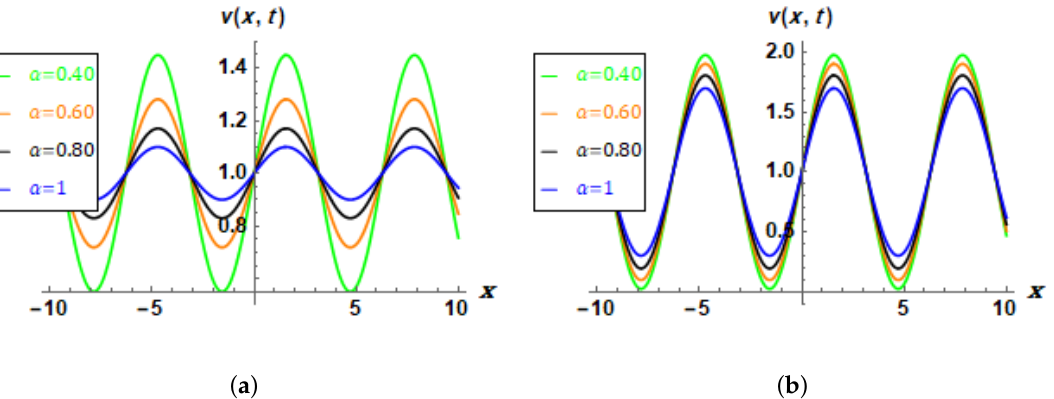
Figure 2. The 2D graphs of the exact solution, ν ( x , t ) , for Equations (34) and (35) at α = 0.4, 0.6, 0.8, 1: ( a ) ν 1 ( x , t ) when t = 0.1, ( b ) ν 1 ( x , t ) when t =